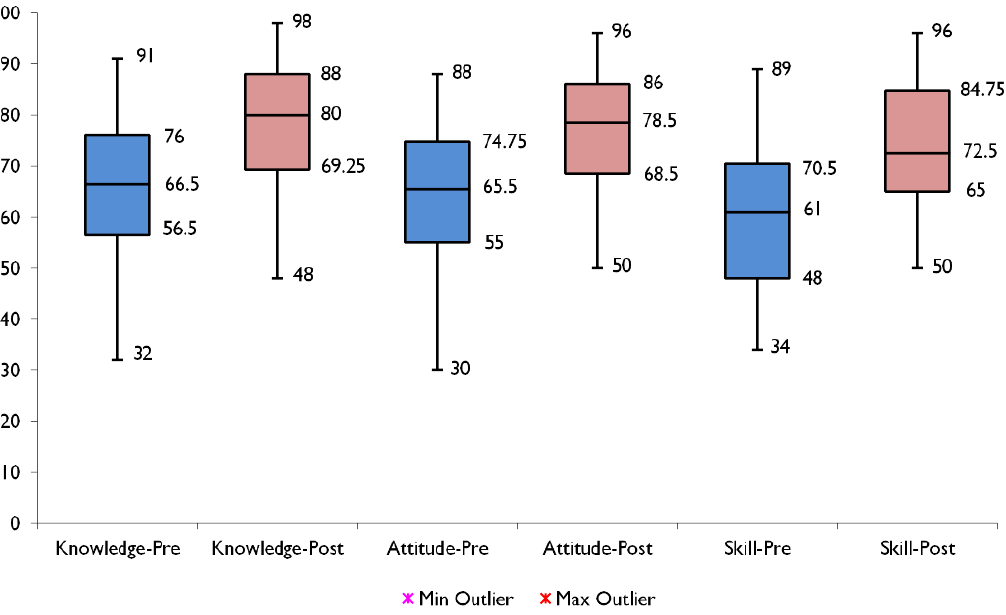
Figure 1. Boxplot graph of nurses’ competency before and after BTCLS